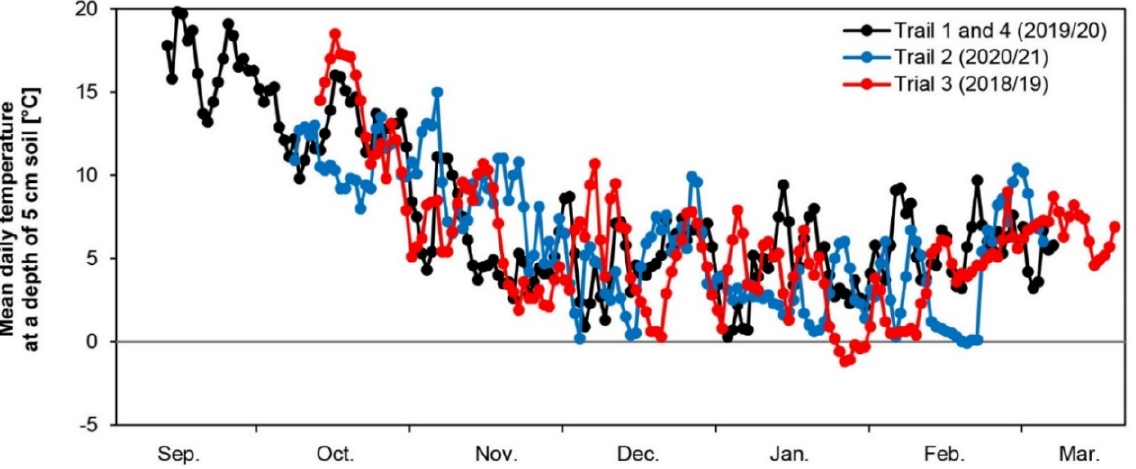
Figure 1. Mean daily temperature at a depth of 5 cm soil from spinach harvest until completion of the trials in March (weather station Borken-Westphalia, Deutscher Wetterdienst, Germany). From October until the completion of trials in early or mid-March, the total precipita- tion was 349–384 L m − 2 (Figure 2). Trial 1 was set up a few weeks earlier than the other trials, resulting in a total precipitation of 502 L m − 2 . Autumn in 2018 (trial 3) was much drier than autumn in 2019 and 2020. Based on visual observations during the soil sampling at the start of each trial, the soil below 30 cm was always drier than the upper soil layer. As a result of the dry autumn in 2018, it took until December until the soil was moistened below 30 cm. In the other years, leaching water reached the 30–60 cm layer by October.